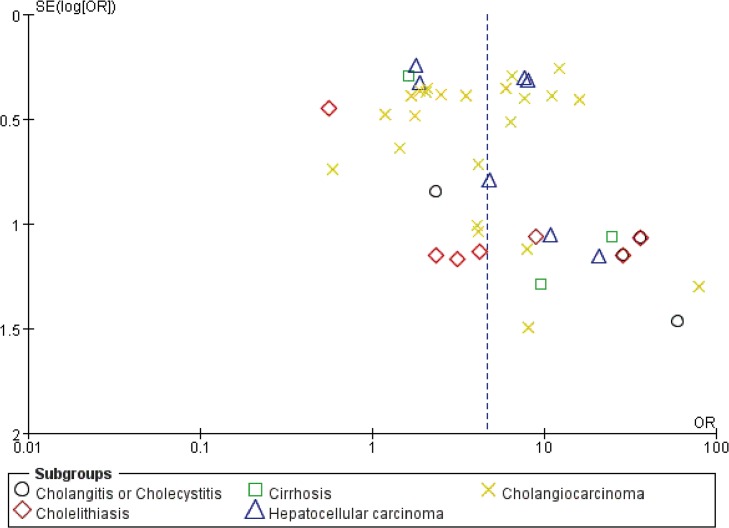
Funnel plot of case-control studies to detect publication bias.